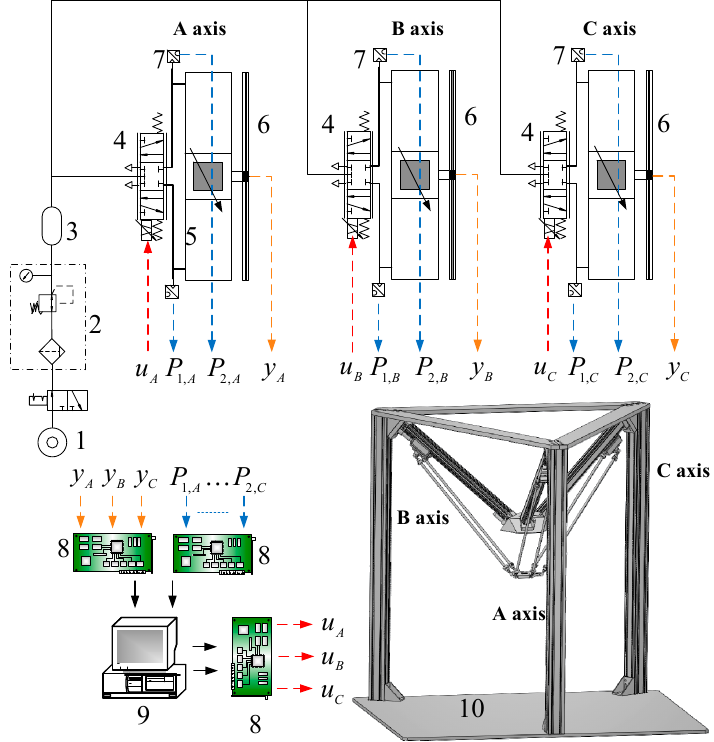
Figure 3. Test rig layout of the 3-DOF pneumatic parallel manipulator. 1: Air Pump; 2: Air Preparation Unit; 3: Air Reservoir; 4: proportional directional control valve; 5: pneumatic rod-less cylinder; 6: optical linear encoder; 7: pressure sensor; 8: interface card; 9: PC-based controller; 10: 3-DOF pneumatic parallel manipulator.